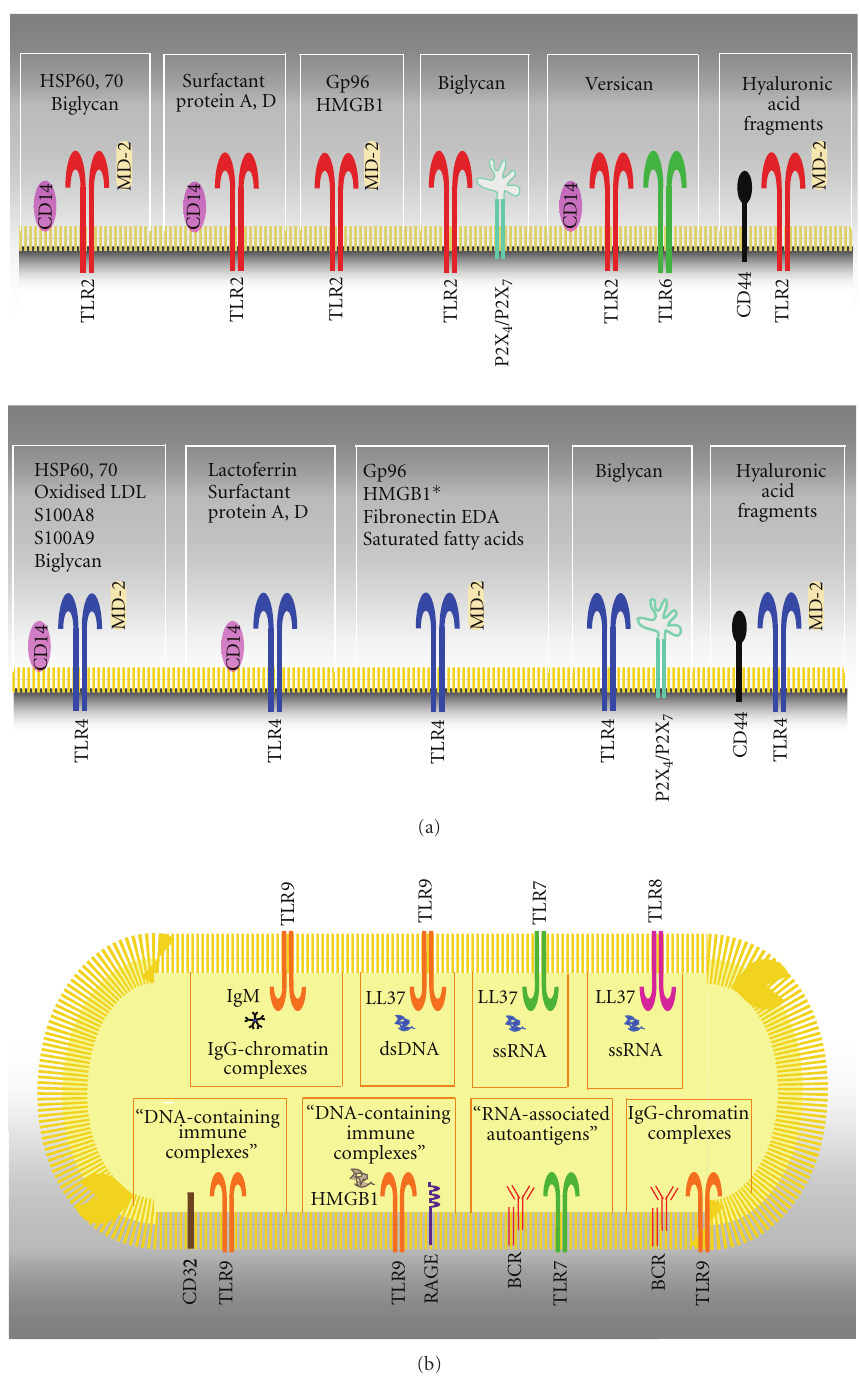
Figure 2: Endogenous ligand recognition by TLRs . The co-receptor(s) and accessory molecule(s) required by DAMPs for recognition by TLR(s) and subsequent cellular activation are shown. (a) TLRs localised on the plasma membrane; (b) TLRs resident in intracellular compartments. ( ∗ )HMGB1 may require MD-2 and CD14 for TLR4 activation (see [96]).